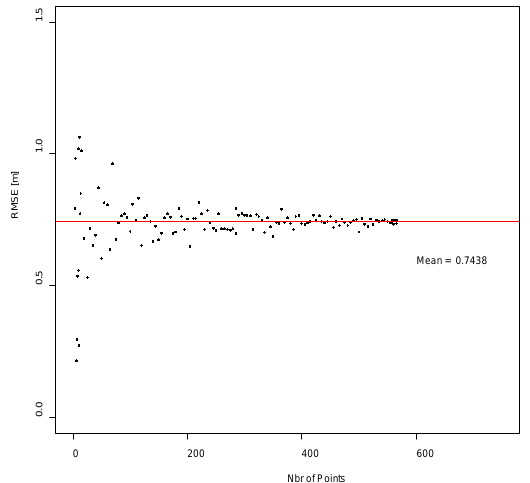
Figure 4. RMSE in relation to the number of GCPs used; the red line represents the mean value